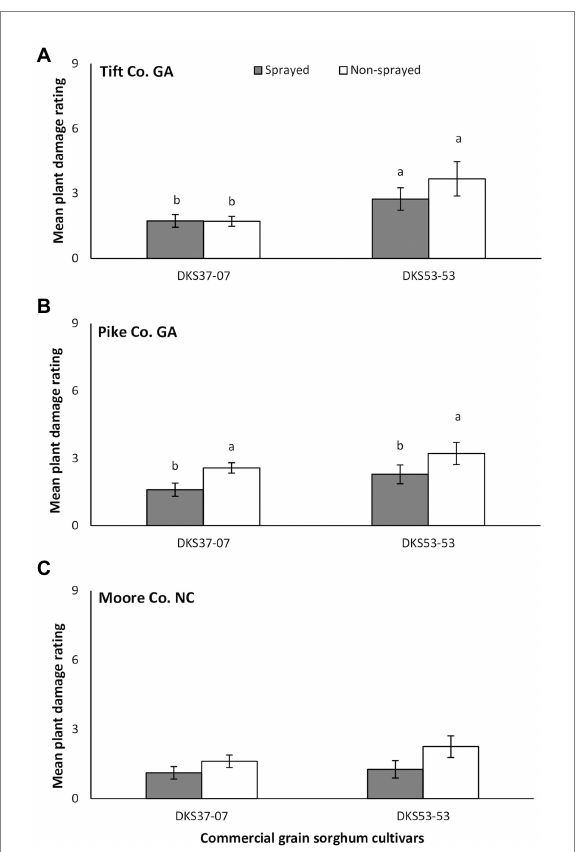
FIGURE 2 Mean (±SE) plant damage rating in flupyradifurone sprayed and non-sprayed grain sorghum cultivars planted at Tift and Pike Co. GA and Moore Co. NC. Means capped with different letters are significantly different (sequential Bonferroni test, p < 0.05) among all four